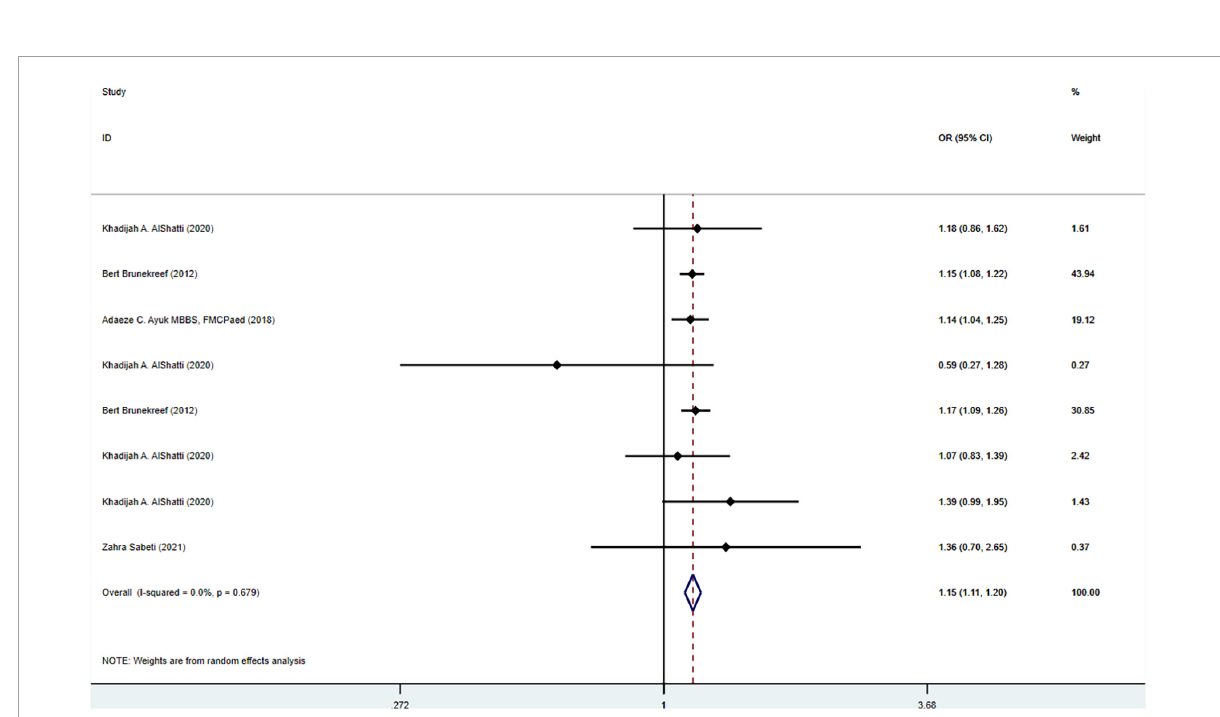
FIGURE6 Forest plot of the association between pet ownership and severe childhood